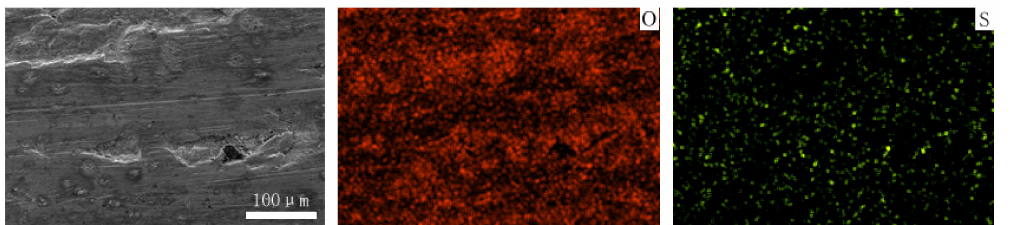
Figure 15. The element distribution of worn surface of NM400 under coal gangue percentage of 50% and pH values of simulated mine water of 3.5.